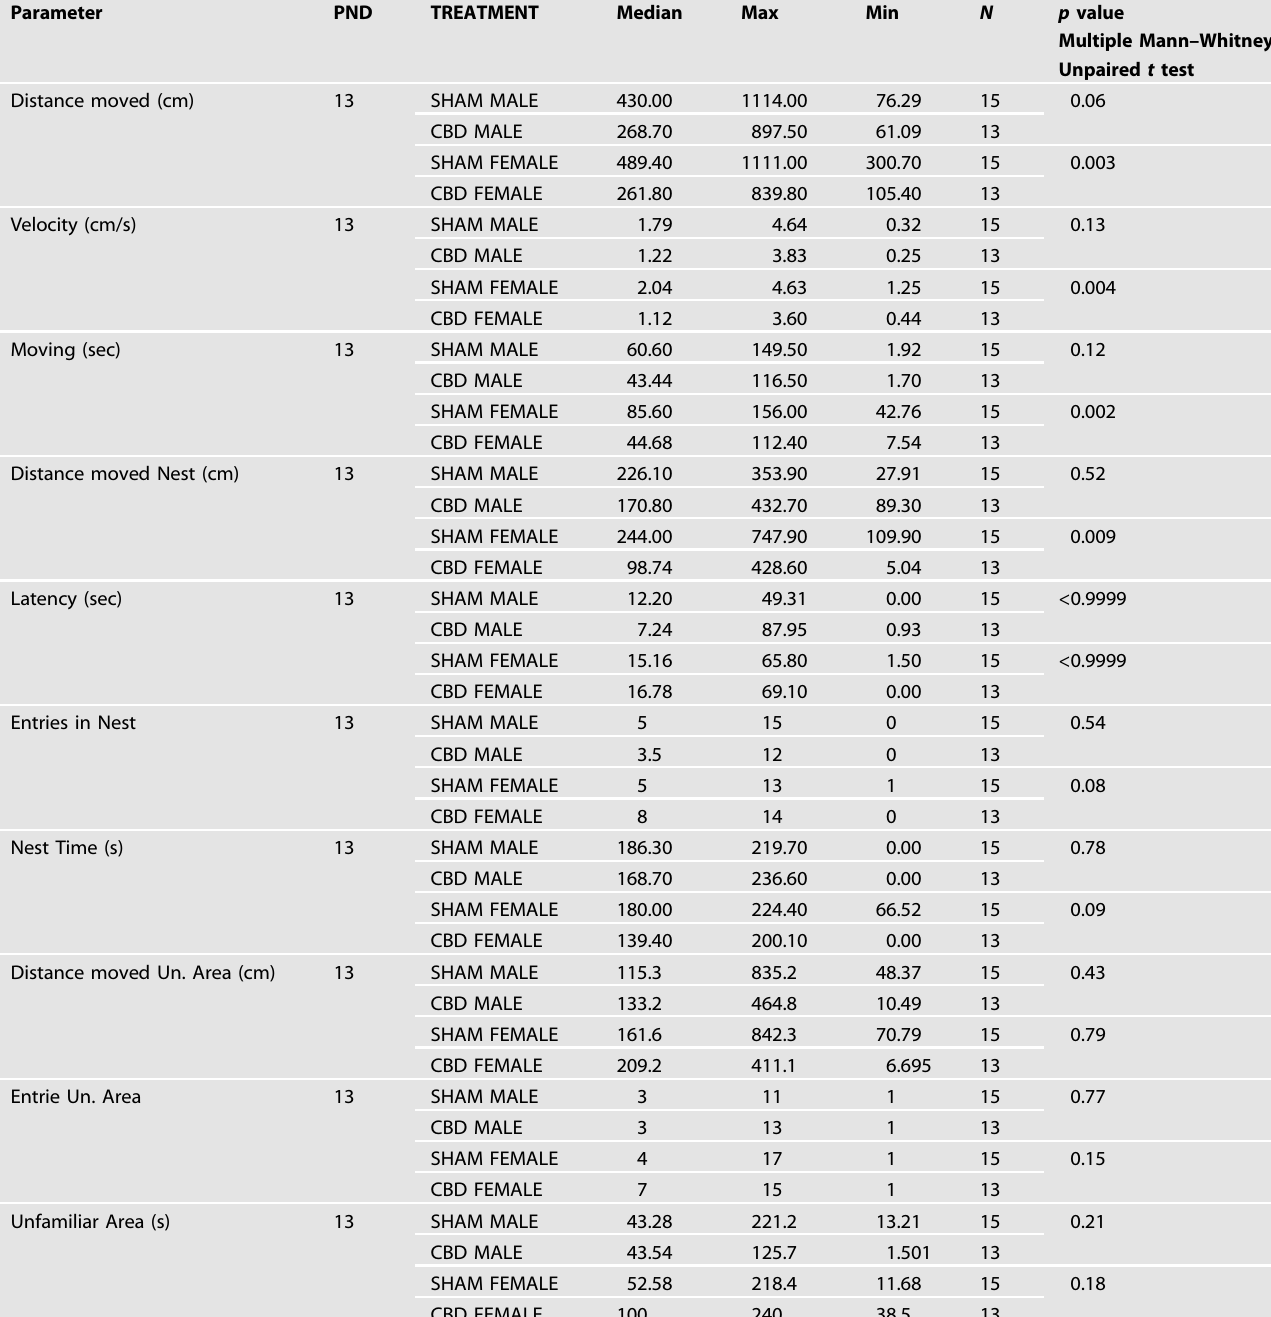
Table 5. Fetal CBD modi fi es homing behavior selectively in female pups.